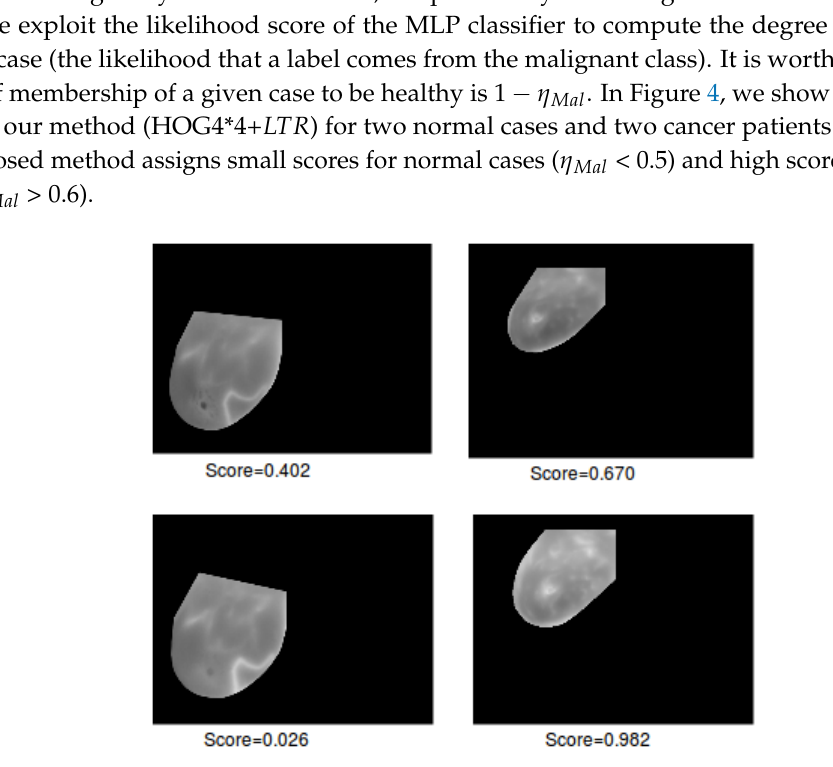
Figure 4. The malignancy score η Mal of two normal cases ( left column ) and two cancer patients ( right column